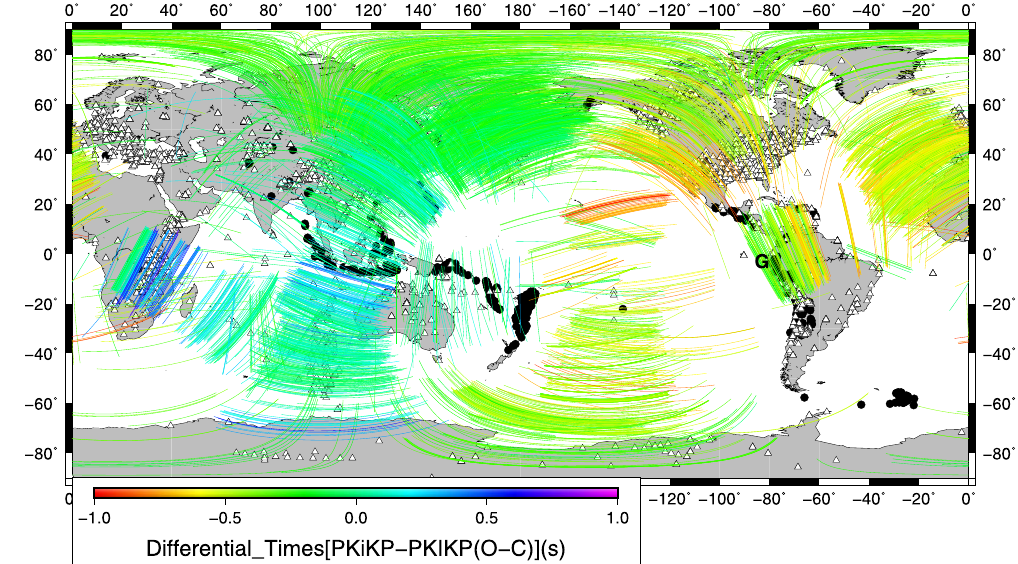
Figure 3. Differential times of PKiKP-PKIKP (O-C) observations. Triangles indicate the seismological stations and black filled circles are the epicenters. Colored lines correspond to the PKIKP paths into the inner core. Pont G at (0°, 80°W) is indicated. Figure produced with Generic Mapping Tools (GMT 5.1.2) 48